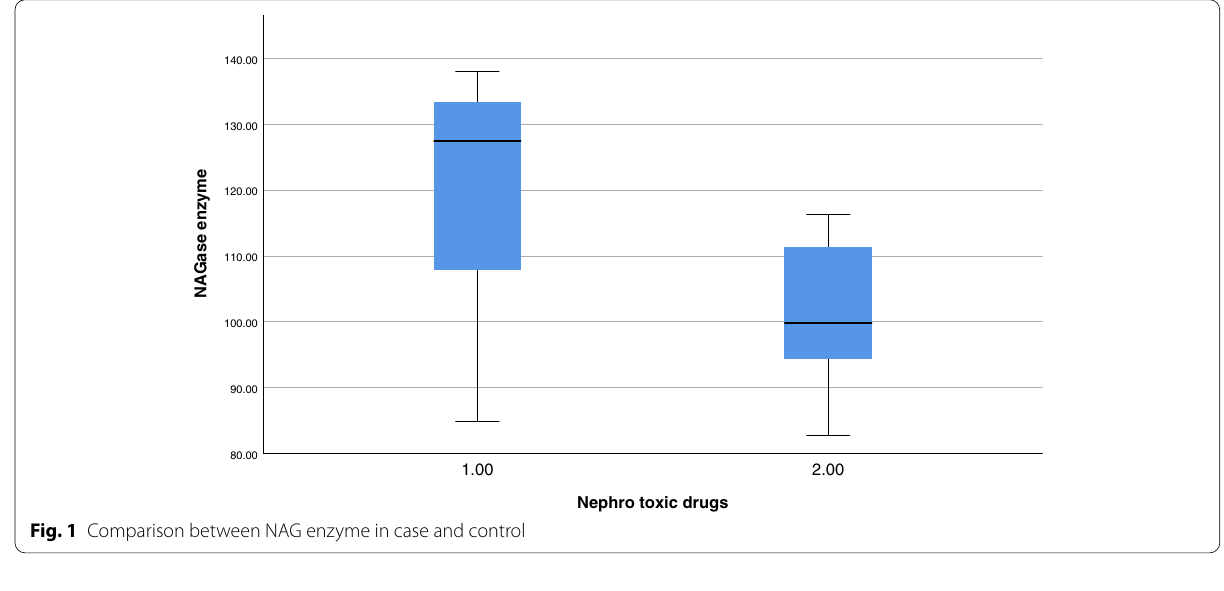
Fig. 1 Comparison between NAG enzyme in case and control